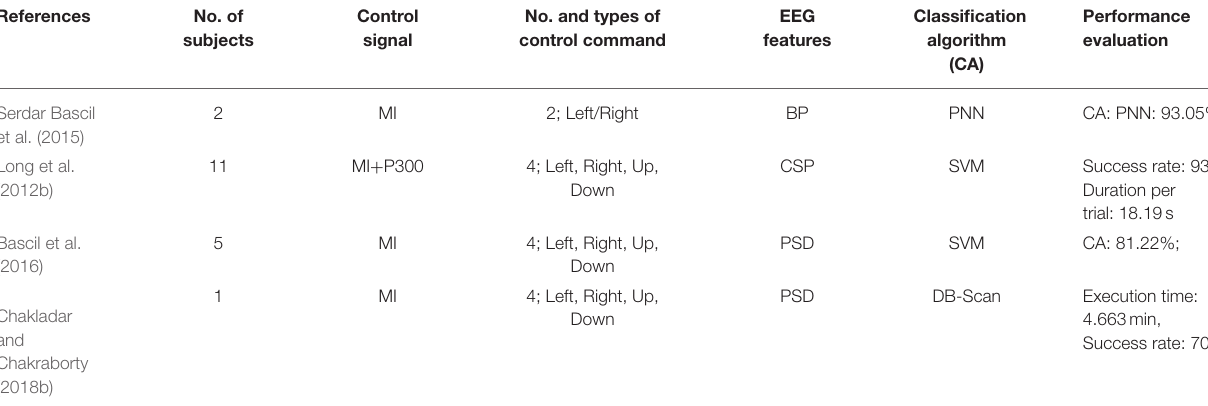
TABLE 4 | Summary of EEG-based BCI cursor control